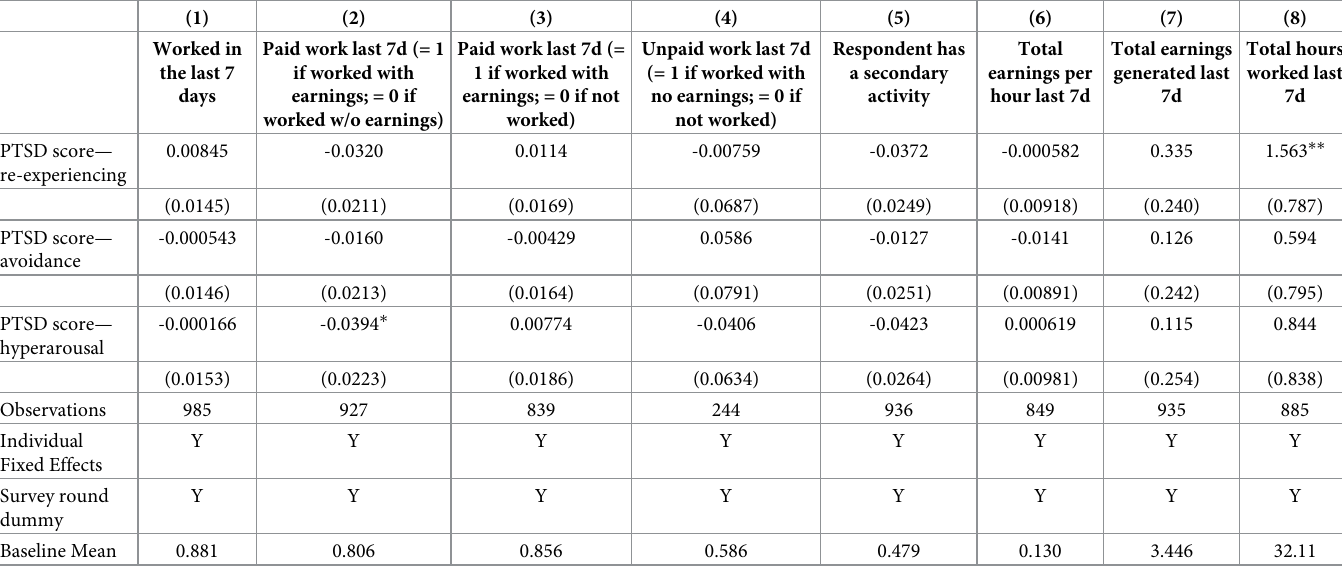
Table 9. Panel regression of women’s work on PTSD symptom clusters.